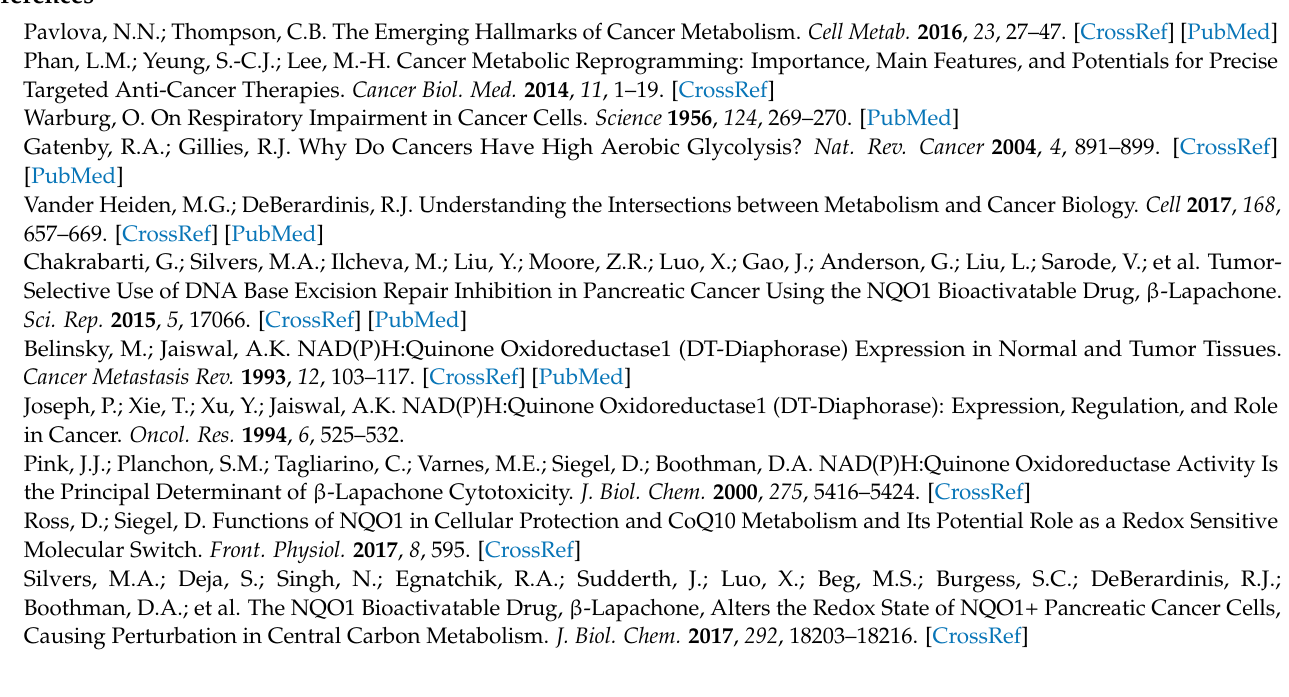
diagram representing the experimental timeline, Figure S9: The 2 H-labeling in the metabolites of control and treated cells, Table S1: Kinetic analysis during β -lapachone treatment, Table S2: Kinetic analysis data of post-treatment